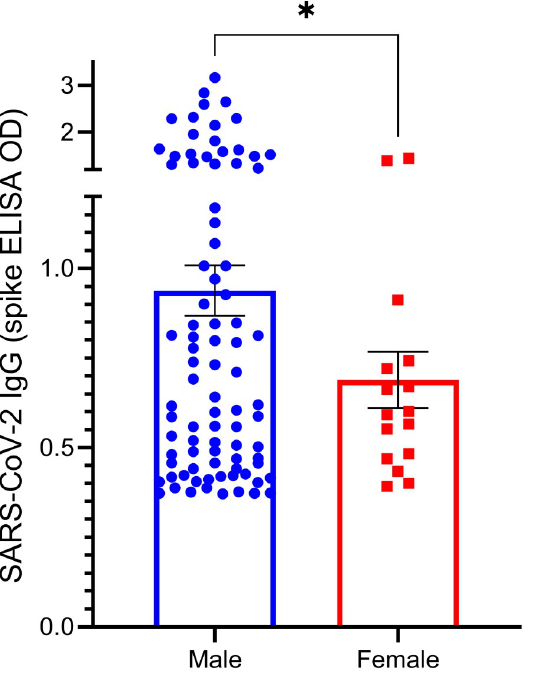
Fig 1. Spike antigen-specific serum IgG levels in males vs. females. The amount of spike antigen -specific IgG was quantitated based on ELISA OD values (Y-axis) and positive test results (OD > 0.356) are compared for males and females. � indicates significant ( p < 0.023) difference between